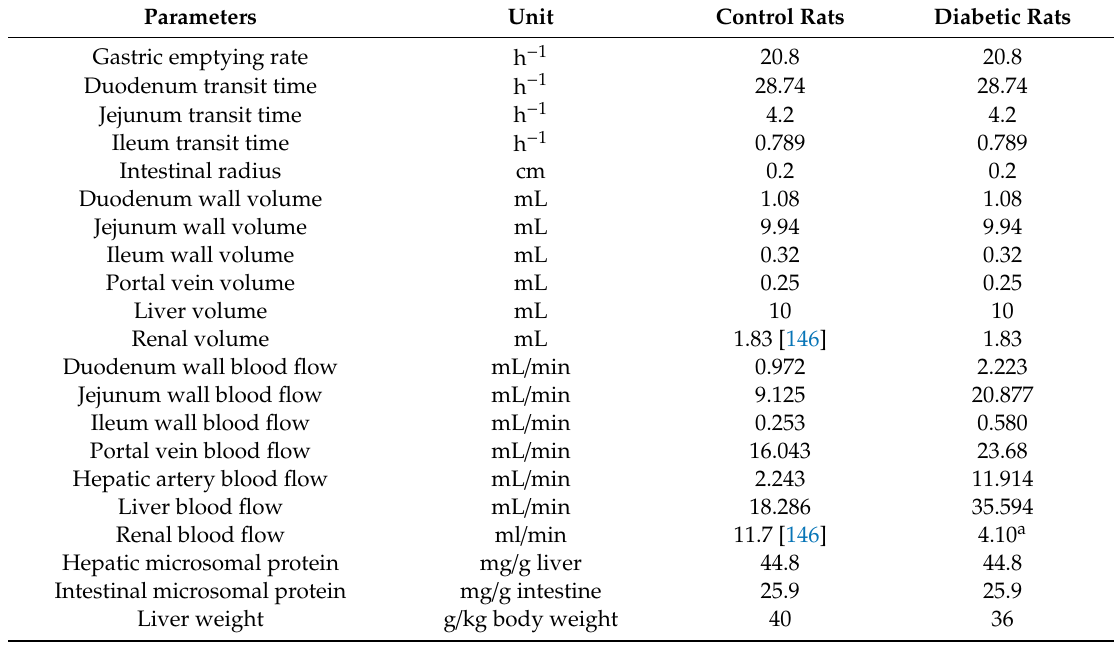
Figure 4. Schematic diagram of semi-physiologically based pharmacokinetic model (PBPK) model describing the pharmacokinetics of verapamil and furosemide in rats. A i , Q i and V i indicate drug amount, blood flow and volume in corresponding compartment, respectively. k i , k a,i and k b,i represent the transit rate constant, drug absorption rate constant and efflux rate constant from enterocytes to the gut lumen, respectively. Cl int,gwi , Cl int,liver and Cl int,kidney mean the intrinsic clearance in enterocytes, hepatocytes and kidney, respectively. Table 1. The physiological parameters of rats for the semi-PBPK model